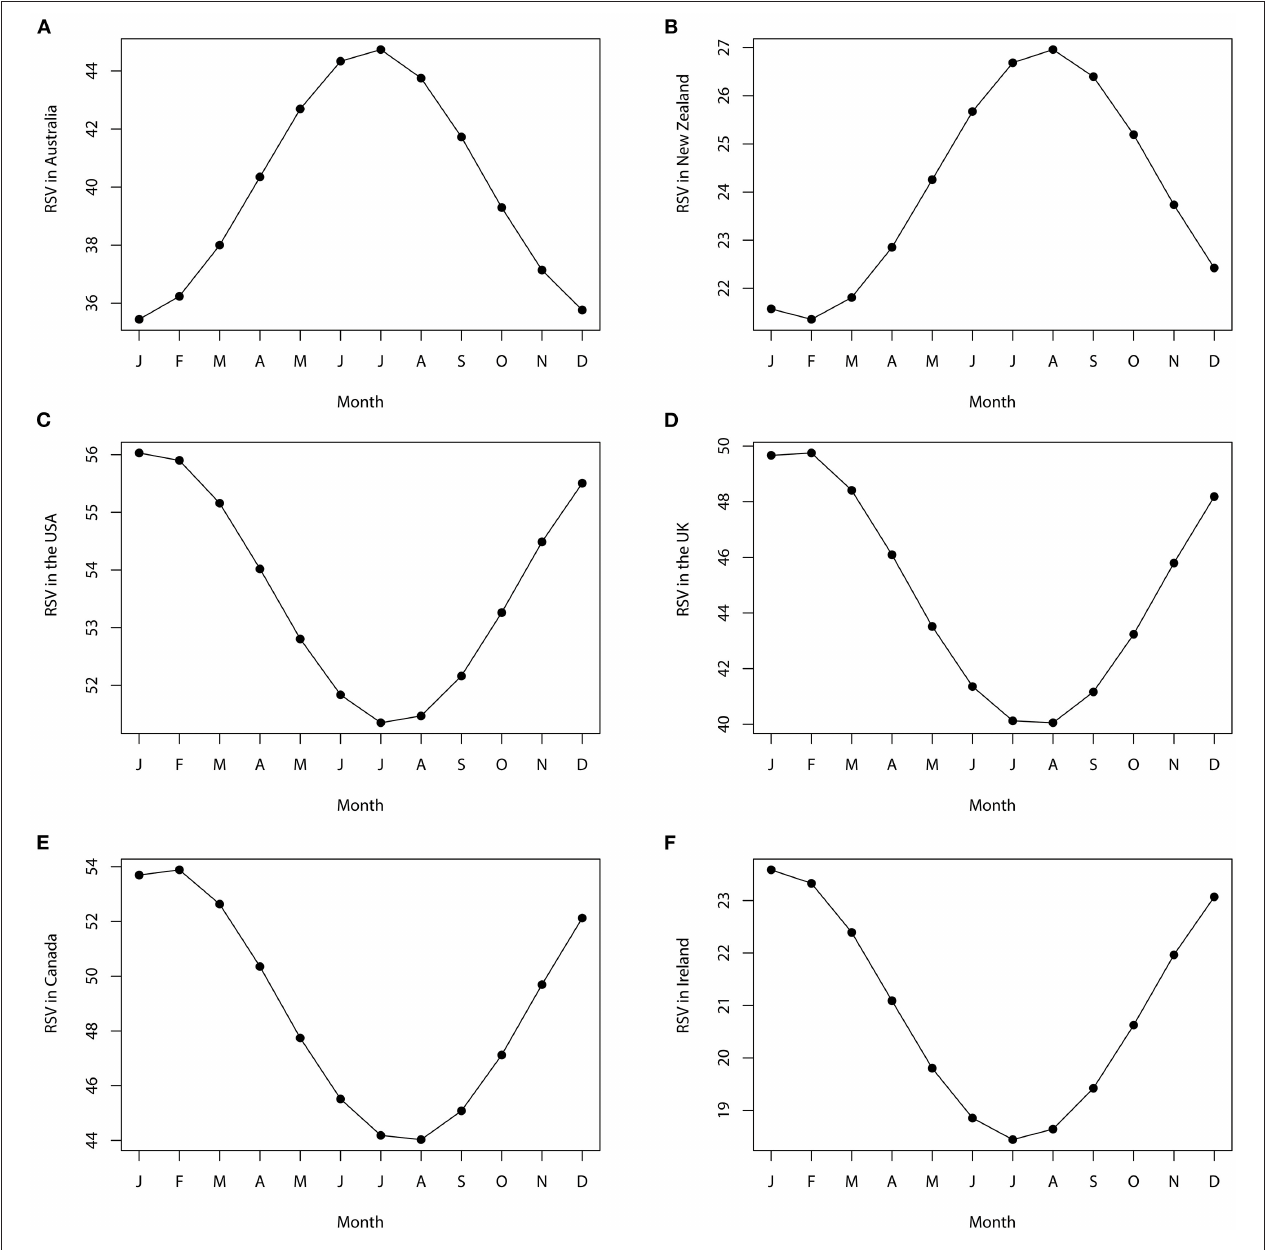
FIGURE 4 | Plots of cosinor models for the seasonal variation of the Alzheimer’s disease-related RSV in (A) Australia, (B) New Zealand, (C) the USA, (D) the UK, (E) Canada, and (F) Ireland from January 2004 to December 2020. The months are as follows: January, February, March, April, May, June, July, August, September, October, November, and December. RSV, relative search